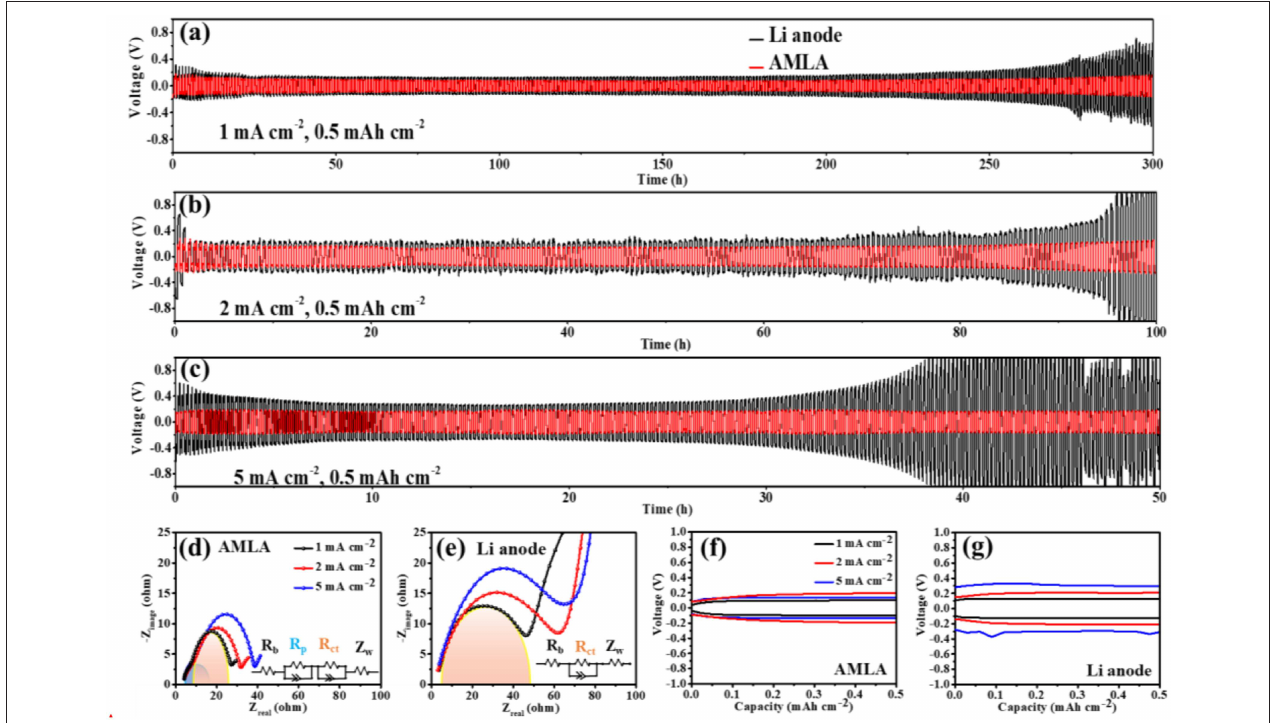
FIGURE 3 | The electrochemical performances of symmetrical cells. (a–c) The voltage-time curves of Li anode (back) and AMLA (red) electrodes under 1, 2, and 5mA cm − 2 current density, the deposit amount of Li + is 0.5 mAh cm − 2 for all the battery. The EIS figures of AMLA (d) and Li anode (e) after 30 times’ cycles under 1mA cm − 2 (black), 2mA cm − 2 (red), and 5mA cm − 2 (blue) current density. The polarization voltage figures of AMLA (f) and Li anode (g) after 30 times’ cycles, under 1mA cm − 2 (black), 2mA cm − 2 (red), and 5mA cm − 2 (blue) current